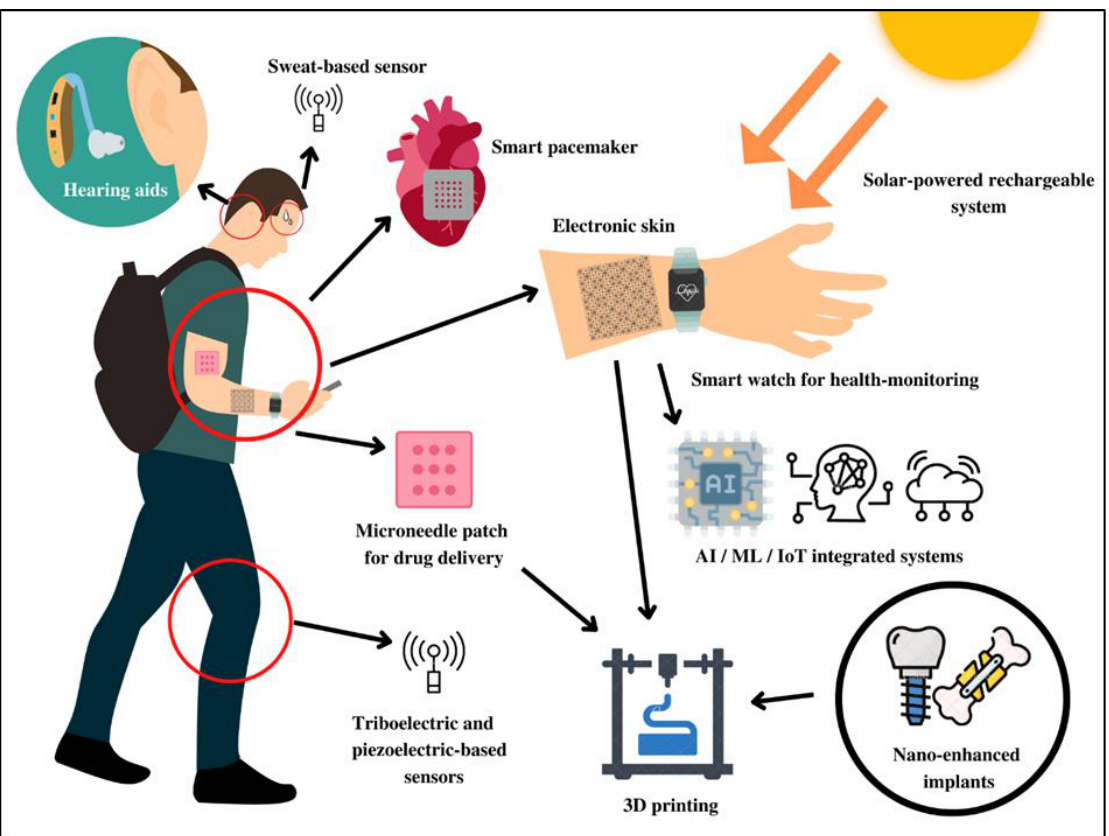
Figure 5. The multifaceted application of smart healthcare electronics fabricated with AI-ML/IoT integrated systems.